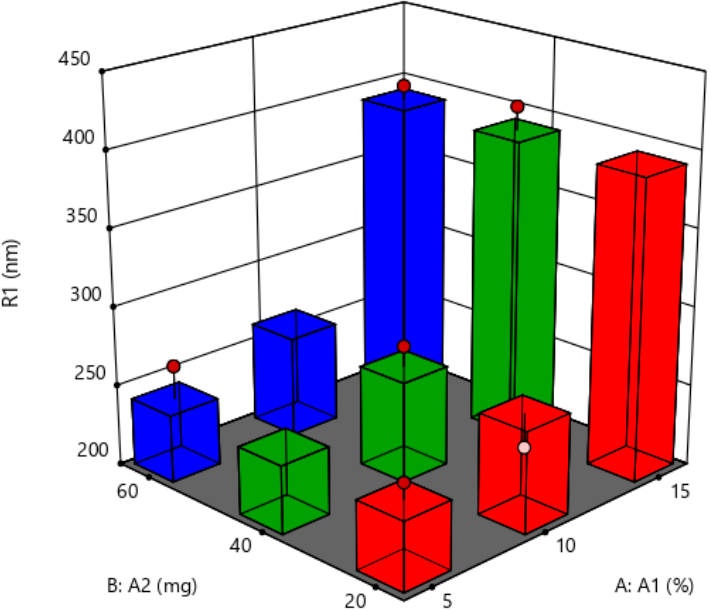
Figure 3. Three-dimensional response surface plot for the dependent variable particle size (R1).